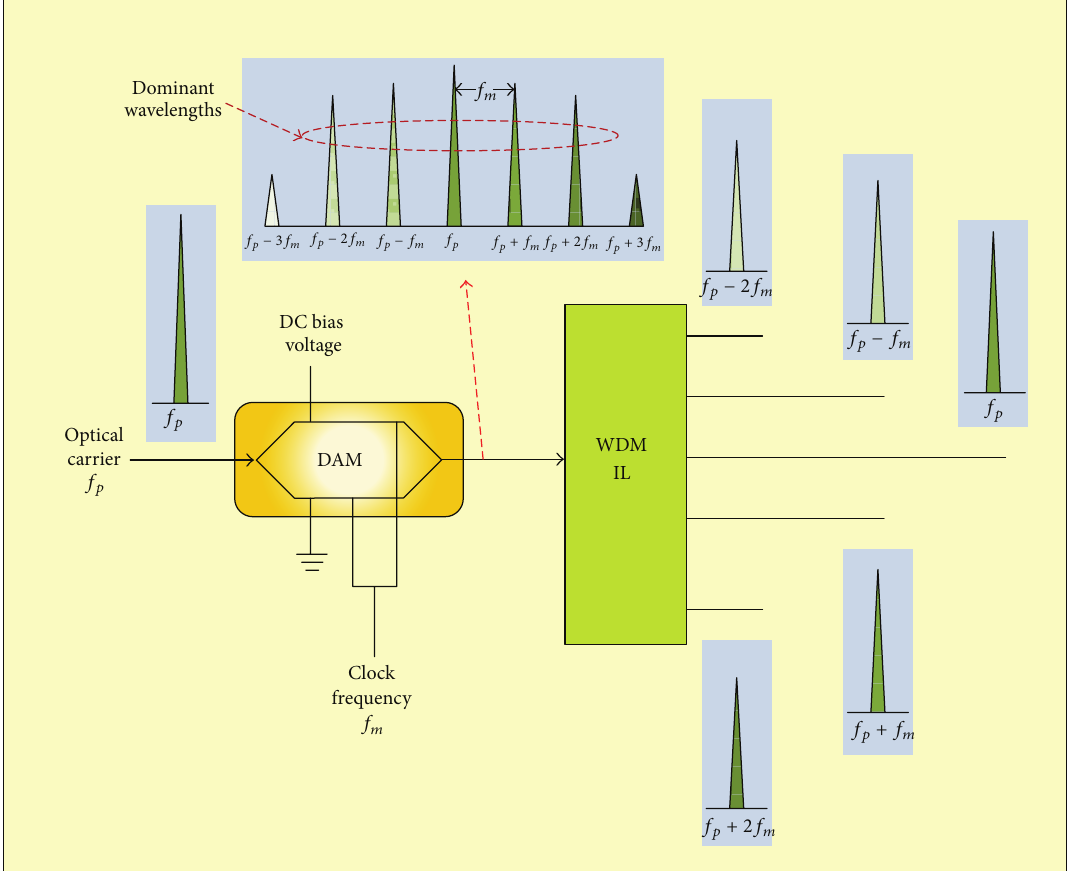
Figure 2: Generation of multiple wavelengths using OFU